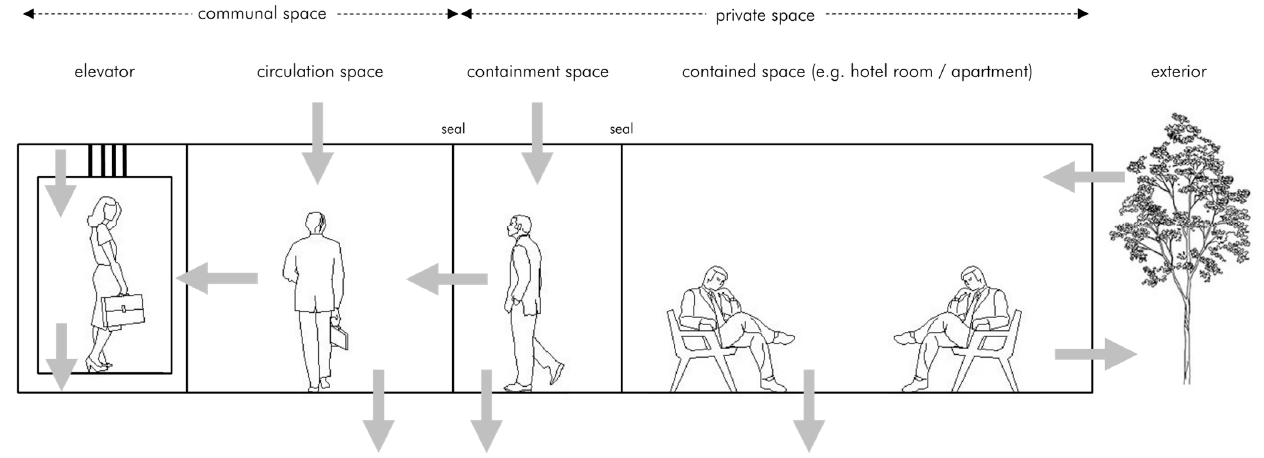
Figure 4. Conceptual model of communal and private spheres in hotel developments and multi-residential complexes.